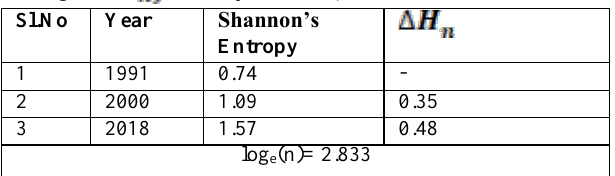
Table 4: Shannon’s entropy with the magnitude of urban sprawl change ( for the years 1991, 2000 and 2018